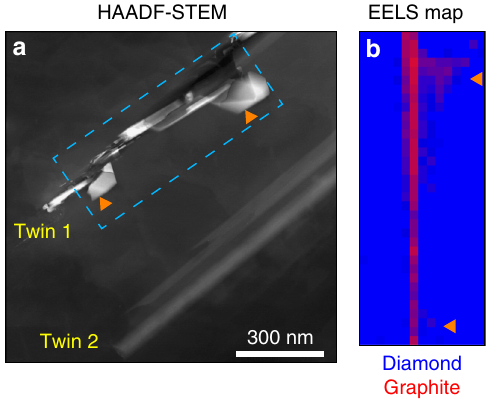
Fig. 1 Graphitization of diamond along twinning directions. a The high-angle annular dark- fi eld (HAADF) STEM image shows two twinning regions indicated as twin 1 and twin 2. Twin 1 is intersecting with two inclusions (indicated by orange arrows) and graphitized, while twin 2 is purely diamond. b The graphite-diamond EELS map (from the dashed blue rectangle in panel a ) indicates that the graphitization is con fi ned to the twinning region and around the inclusions (red = graphite, blue =